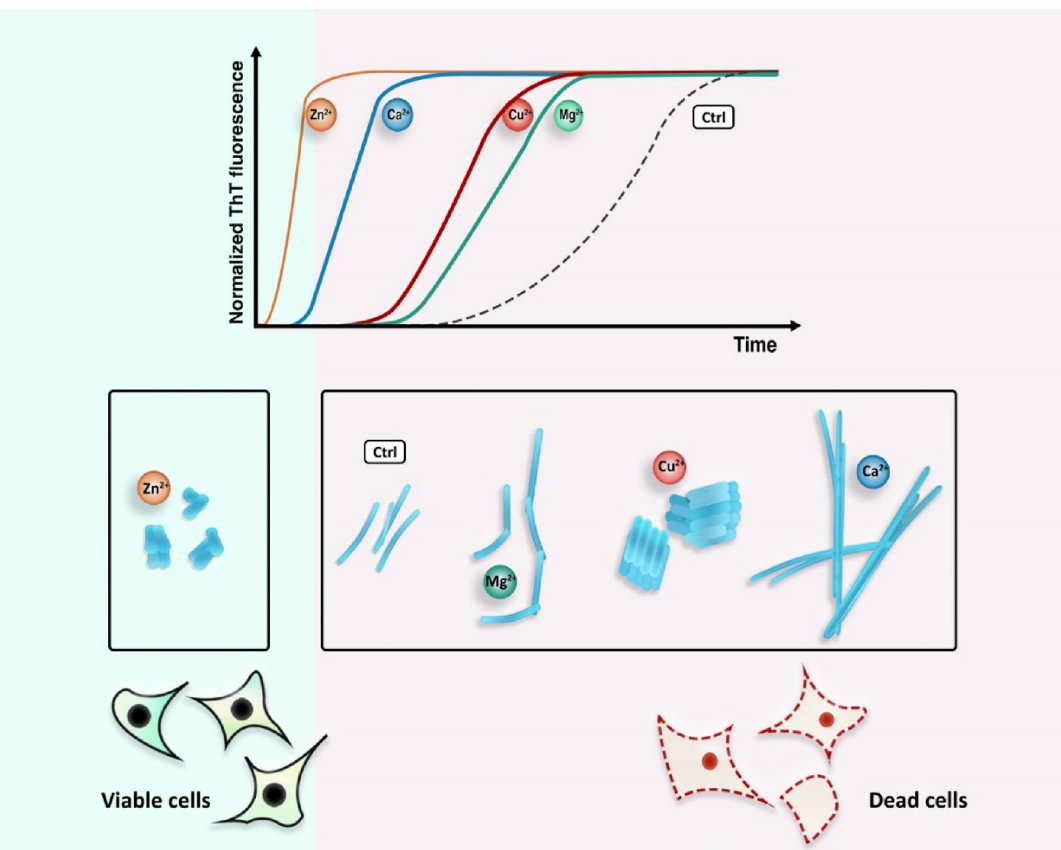
Figure 7. Schematic representation displaying the effect of various cations on α-Synuclein fibril formation. Various metal ions induced accelerated rate of α-Syn fibrillation and formation of polymorphically different fibrils. The fibrils produced in the presence of Zn 2+ ions were less cytotoxic compared to the fibrils produced in the absence of cations or formed in the presence of Cu 2+ , Ca 2+ , and Mg 2+ . The schematic image was drawn using Photoshop CS5